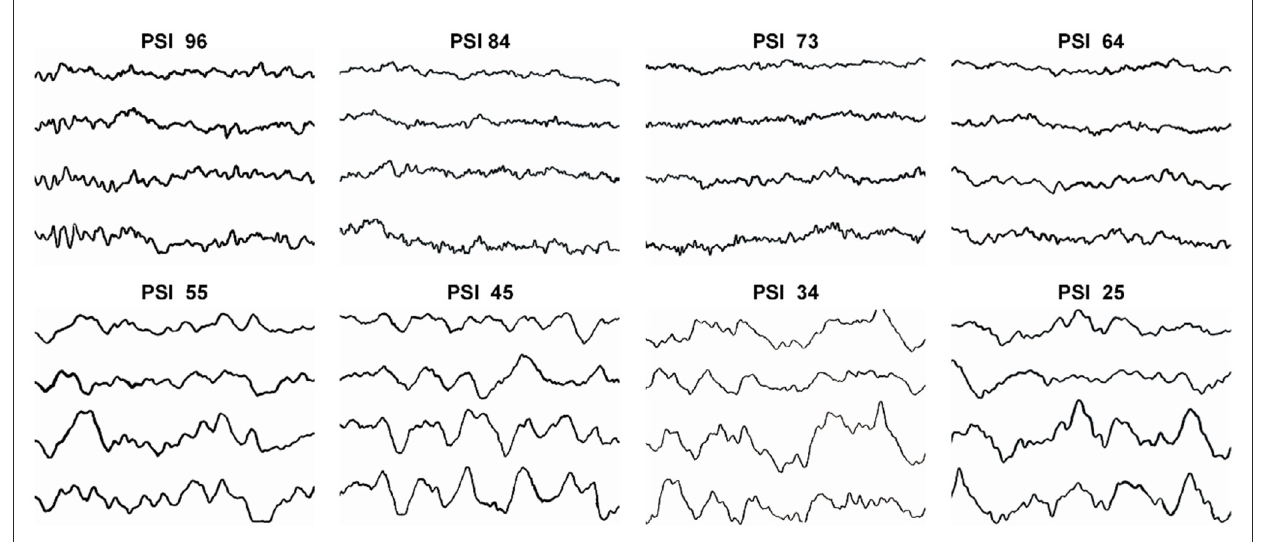
FIGURE5 The typical patterns and the characteristic changes of EEG when PSI scores were 96, 84, 73, 64, 55, 45, 34, and 25 during DEX induction.